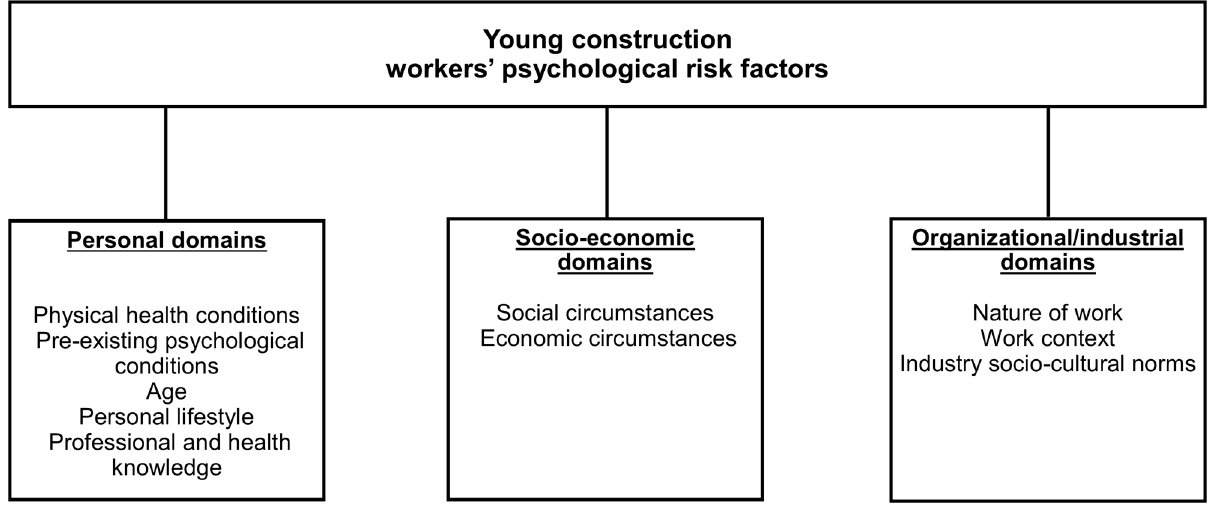
Figure 2. Domains of psychosocial risk factors affecting young construction workers. Table 1. Variable ranks of domains of psychosocial risk factors.